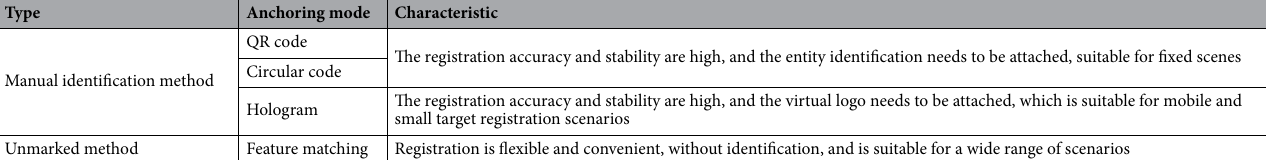
Table 2. Virtual reality registration method based on machine vision.